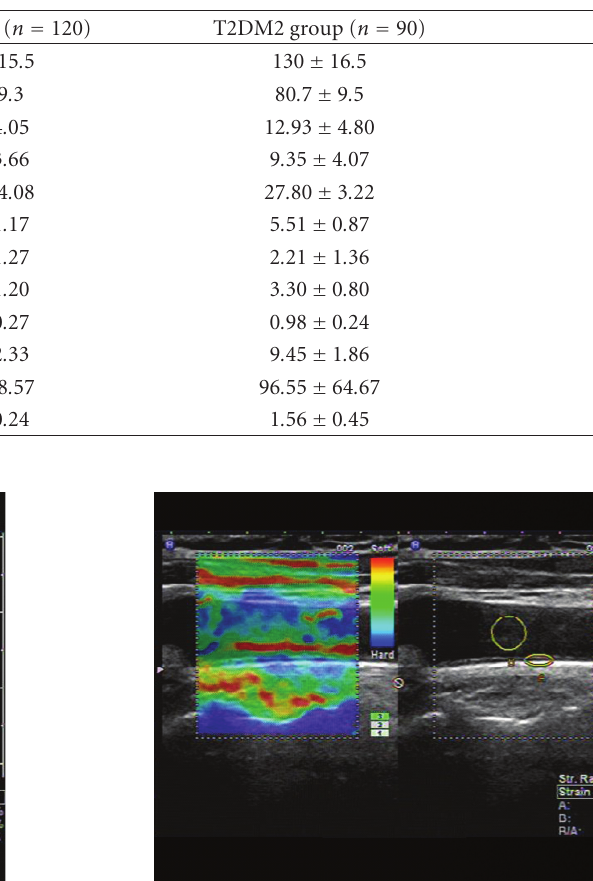
Table 1: Characteristics of two groups.